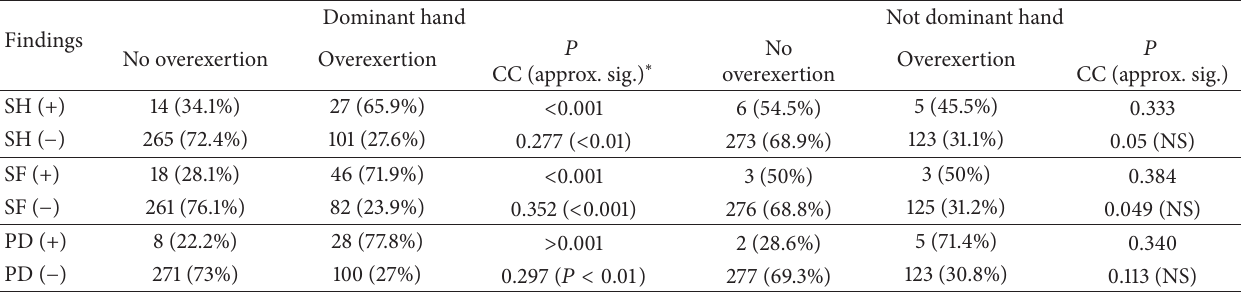
Table 2: Findings in carpal joints grouped according to the hand dominance.